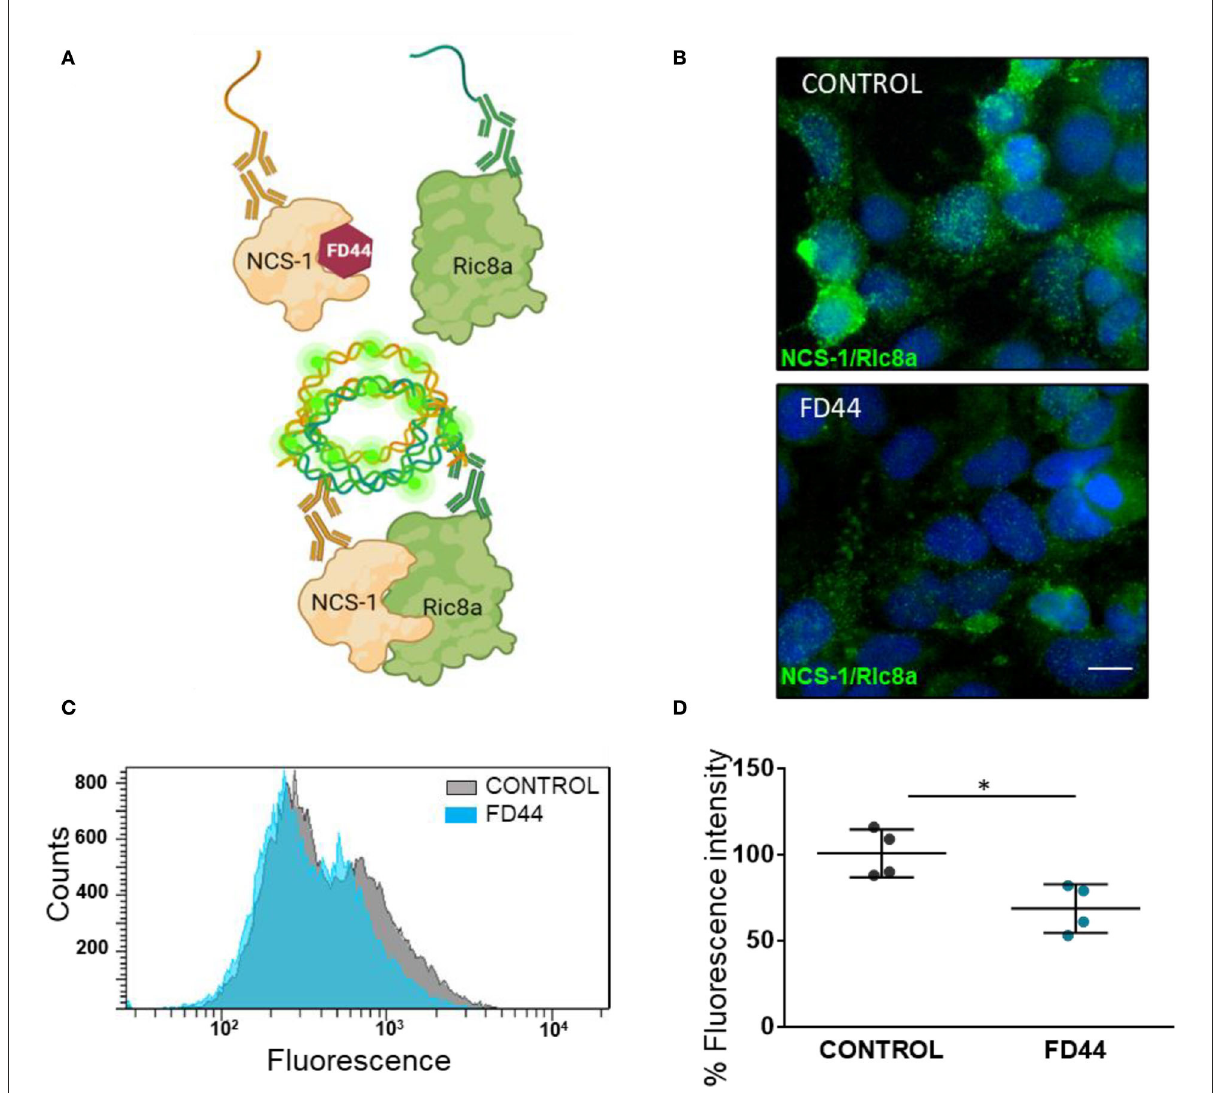
FIGURE1 In situ analysis of neuronal calcium sensor 1 (NCS-1) binding to Ric8a. (A) Schematic representation of the basis of a proximity ligation assay (PLA) for the study of the NCS-1/Ric8a interaction. FD44 blocks the binding of Ric8a by making the NCS-1 interaction crevice unavailable for Ric8a. When the complex is not formed, probes of the PLA secondary antibodies do not bind, and no fluorescence is detected. In contrast when FD44 is not present, the complex is formed, the probes ligate and subsequently elongate, and fluorescence is detected. (B) PLA was performed in HEK293 co-transfected with NCS-1 and Ric8a-V5 and treated the last 24h with vehicle (V; control) or FD44 (20 µ M). After fixation, PLA was performed and a green fluorescence probe was used to reveal the binding. Nuclei are labeled with Hoechst. Scale bar corresponds to 10 µ m. (C) PLA was performed as in B, but in this case cells were analyzed by flow cytometry. The histogram showing the number of cells (counts) per green fluorescence of a representative experiment is shown. (D) Graph showing the mean fluorescence intensity of treated HEK293 overexpressing NCS-1 and Ric8a-V5 following fixation and PLA for flow cytometry. Graph represents 15,000 cells in four independent experiments. Values are expressed as mean ± standard deviation (SD) n = 4. Statistical analysis performed by Student’s t -test. * p < 0.05, NCS-1/Ric8a treated with solvent (CONTROL), NCS-1/Ric8a treated with FD44